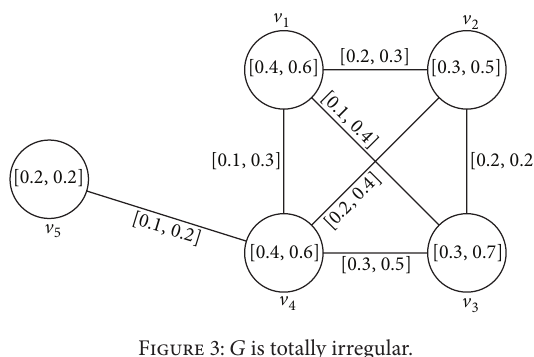
Figure 3: 𝐺 is totally irregular.